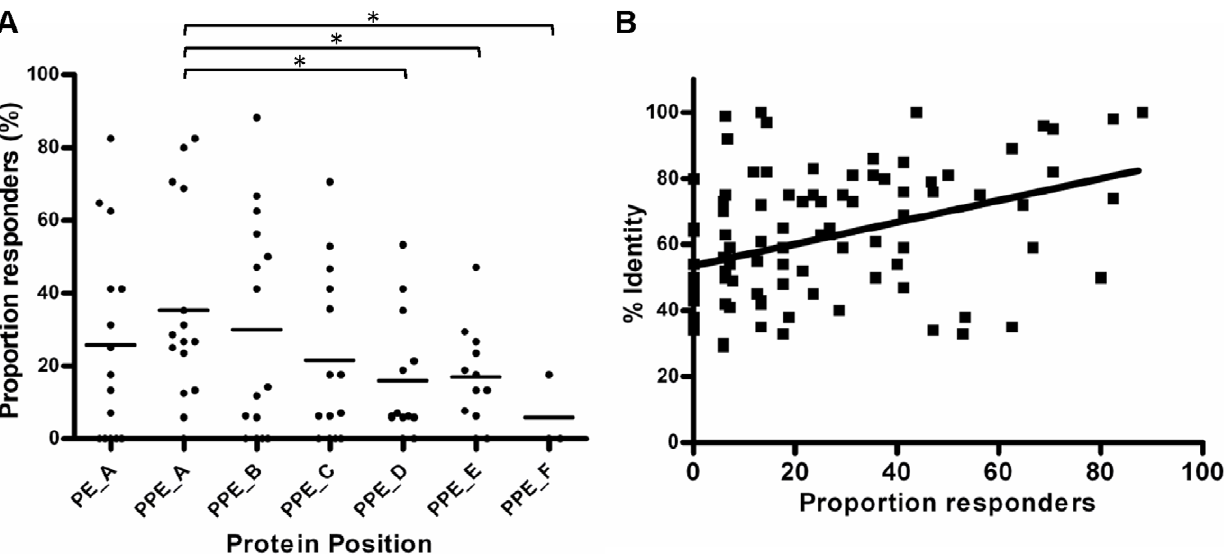
Figure 5. Immune recognition correlates with sequence conservation. (A) IFN- c responses were measured following stimulation of whole bovine blood with PE/PPE peptide pools, and scored as positive if D OD 450 values were $ 0.1. The proportion of responders was plotted along the length of the PE/PPE proteins, where A corresponds to the peptide pool closest to the N-terminal. *, 2-tailed p value , 0.05 (unpaired t-test). The letters A to F denote the position of the peptide pool across the length of the protein, with A nearest the N-terminal. PE_A represents the conserved 110 aa region, while PPE_A and PPE_B encompasses the conserved 180 aa region of the PPE proteins. (B) The proportion responders to PE/PPE peptide pools was plotted against % identity, which corresponds to the % identity of the amino acid sequence corresponding to that pool to its closest match in the M. tuberculosis genome sequence. Linear regression analysis produced the line shown. A Spearman correlation test indicated revealed a statistically significant correlation between % identity and proportion bovine responders; rho(98) =0.401, 2-tailed p value , 0.0001.